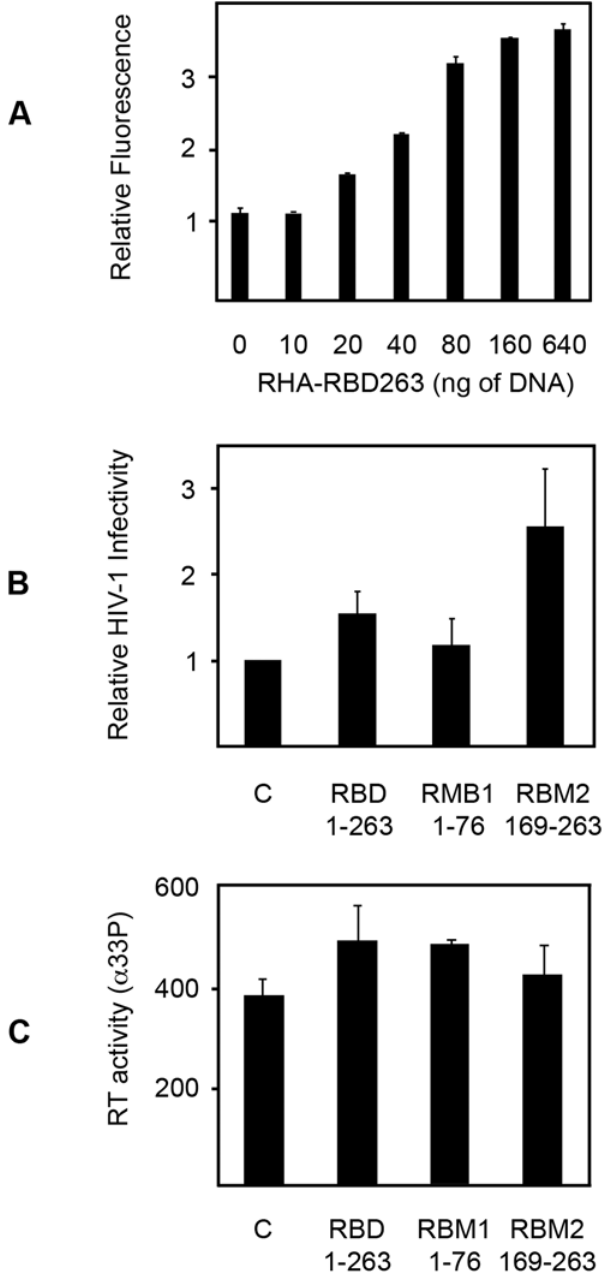
Figure 6. The RBD of RHA enhances HIV-1 infectivity. (A) The graph shows RHA-regulated, LTR-expression is increased in HEK293T cells in proportion to increasing amounts of the N-terminal RHA RBM. Values are normalized to equivalent levels of an empty control plasmid. Error bars represent standard deviations. (B) The effect of different RHA constructs on HIV-1 infectivity was assessed using recombinant virus in the T-cell line MT-2. Values were normalized to HIV-1 produced with an empty control vector. Each value is the average of three independent experiments with replicates. The error bars represent the standard deviations. (C) A bar graph representing the relative replication capacity of HIV-1 produced with different RHA or control constructs (RBD, RBM1, and RBM2). Viral replication is measured by assaying reverse transcriptase activity. The values shown are an average of four replicates. Error bars show the standard